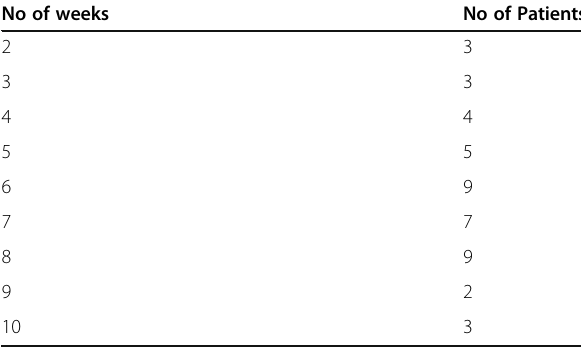
Table 3 Last injection before conception (weeks)